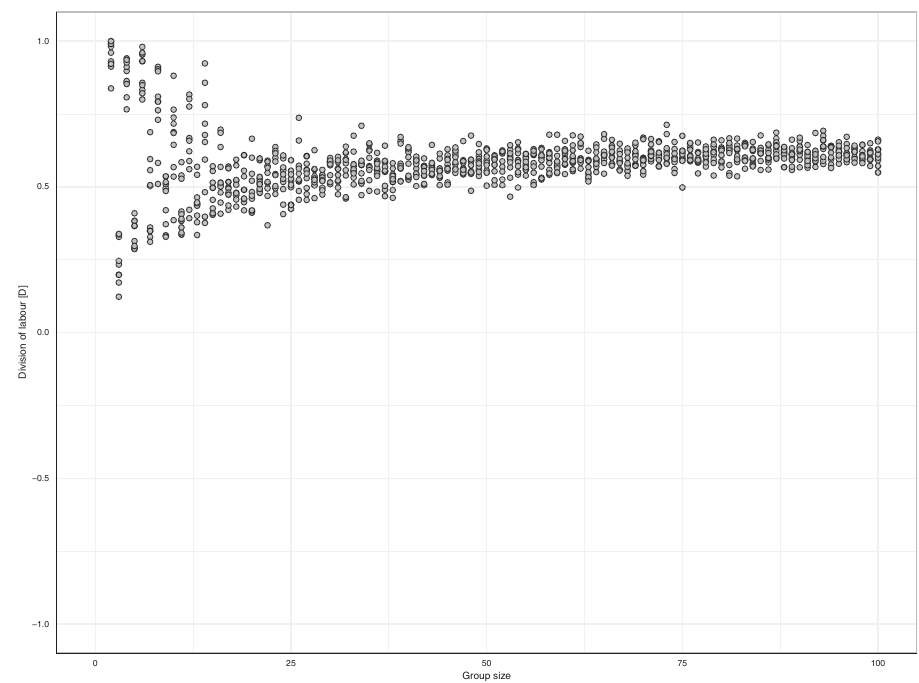
Fig. 5 | Effect of group size on division of labour in the equal sharing scenario. Division of labour emerges irrespective of group size. Each dot shows the division-of- labour metric from a replicate simulation per group size ( n